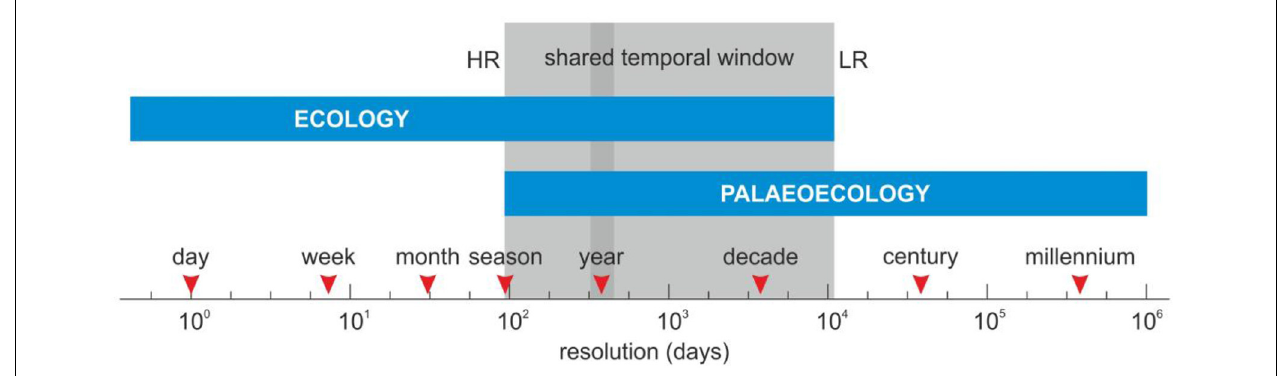
FIGURE 1 | Timescales of ecological and palaeoecological studies showing the shared temporal window, ranging from seasons to decades. The higher resolution (HR) of combined ecological- palaeoecological time series is attained using seasonal records, whereas